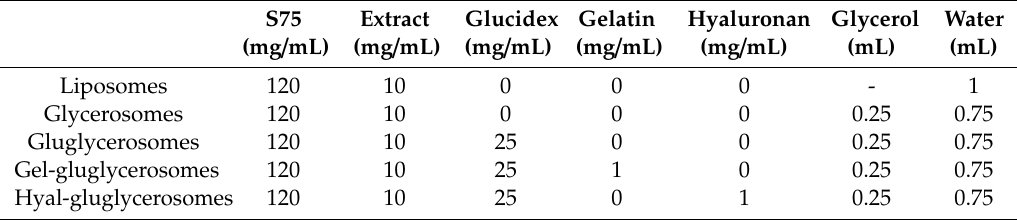
Table 1. Composition of Hypericum scruglii extract-loaded